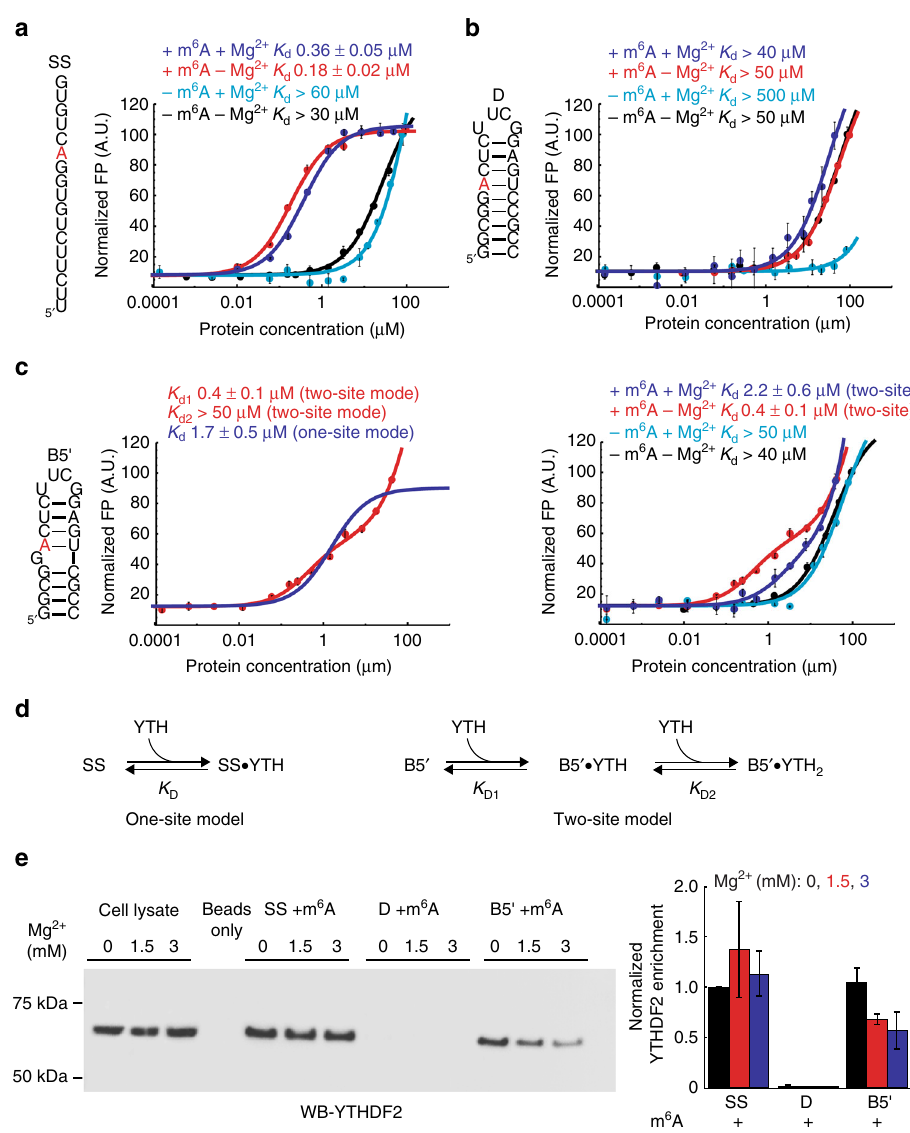
Fig. 4 YTH recognizes m 6 A in B5 ʹ but not D. a – c Binding curves for YTH domain with a SS, b D, and c B5 ʹ . d One-site and independent two-site binding models used for curve fi tting. Data is shown for unmodi fi ed and methylated RNA with and without 3 mM Mg 2 + . Uncertainty re fl ects the standard deviation from three measurements. ( c , left) Fits to the data assuming single (blue) versus two independent (red) binding sites (see Methods). e In vitro RNA pulldown assay using 5 ʹ biotinylated RNA constructs with m 6 A. Showing YTHDF2 binds preferentially to m 6 A in unpaired context or at the junction, and Mg 2 + decreases the enrichment of YTHDF2 by methylated B5 ʹ . Blots shown are representative of results from three experiments. Uncropped blots are shown in Supplementary Fig. 6. The semi-quantitative YTHDF2 enrichment analysis was performed using ImageJ 56 . The uncertainty represents the standard deviation from three the data is better fi t to a model that assumes two independent binding sites (Fig. 4d). A similar behavior was previously observed for YTH domain binding to methylated ssRNA 45 .